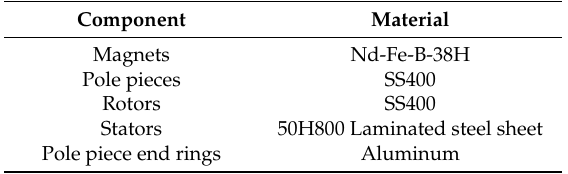
Table 2. Material properties.